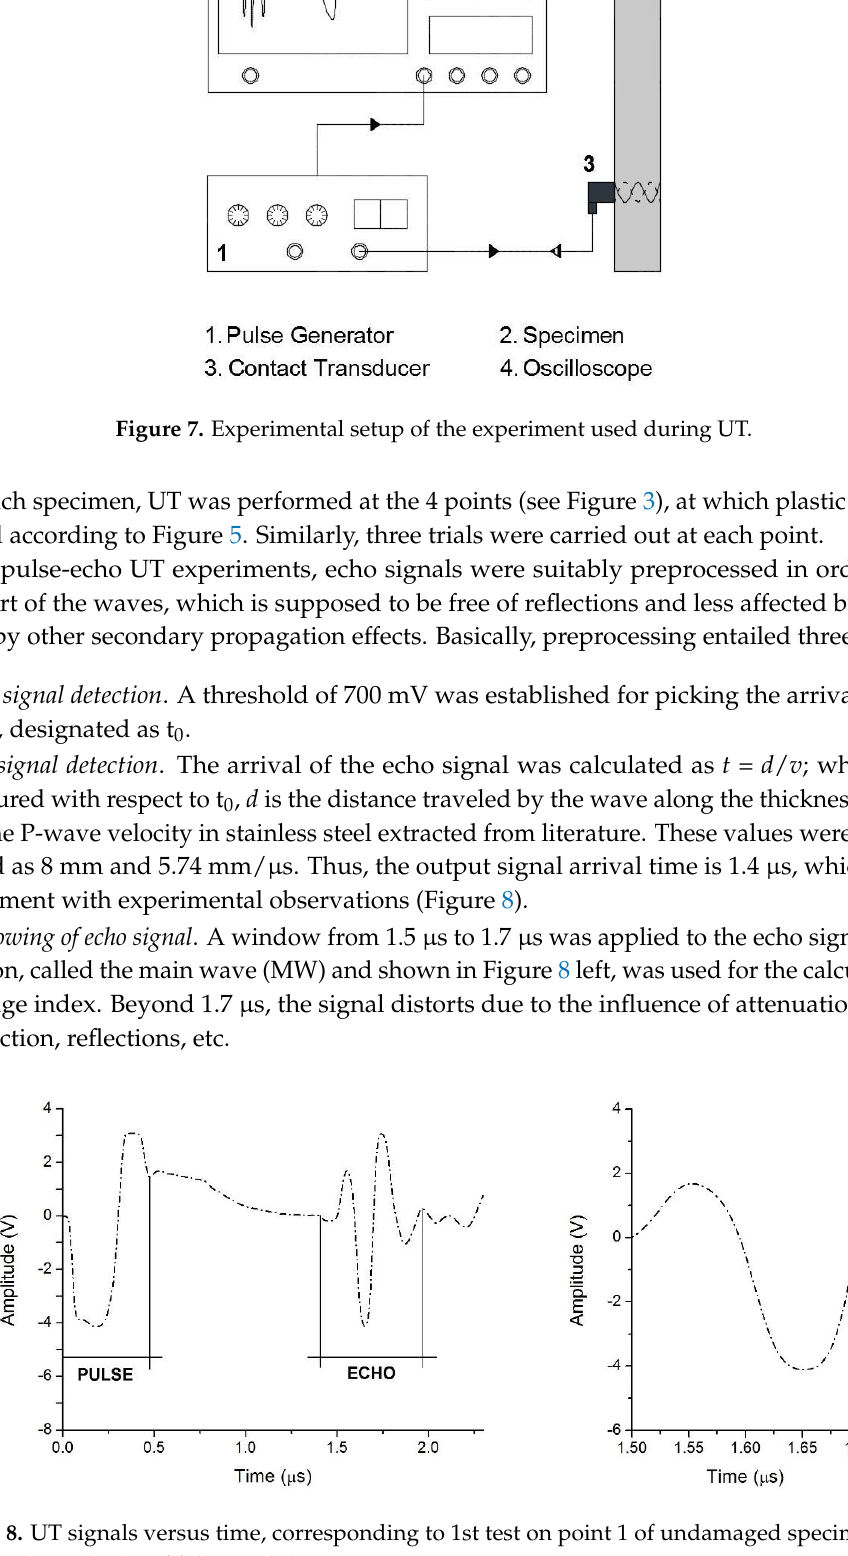
Figure 9. Main Waves extracted from 2nd trial on point 2 of undamaged state D 0 and damaged states D 1 – D 5 . Second loading pattern. 5. Proposed Damage Index The MW extracted from the echo signals was carefully processed in order to calculate a proposed UT damage index. Firstly, the Fast Fourier Transform (FFT) was applied to the MW in order to obtain its frequency spectrum [14,15]. In the case of MW signals, spectrums show a central frequency around 5 MHz, and a spectral energy between 0 and 12 MHz named E s , as Figure 10 schematized.